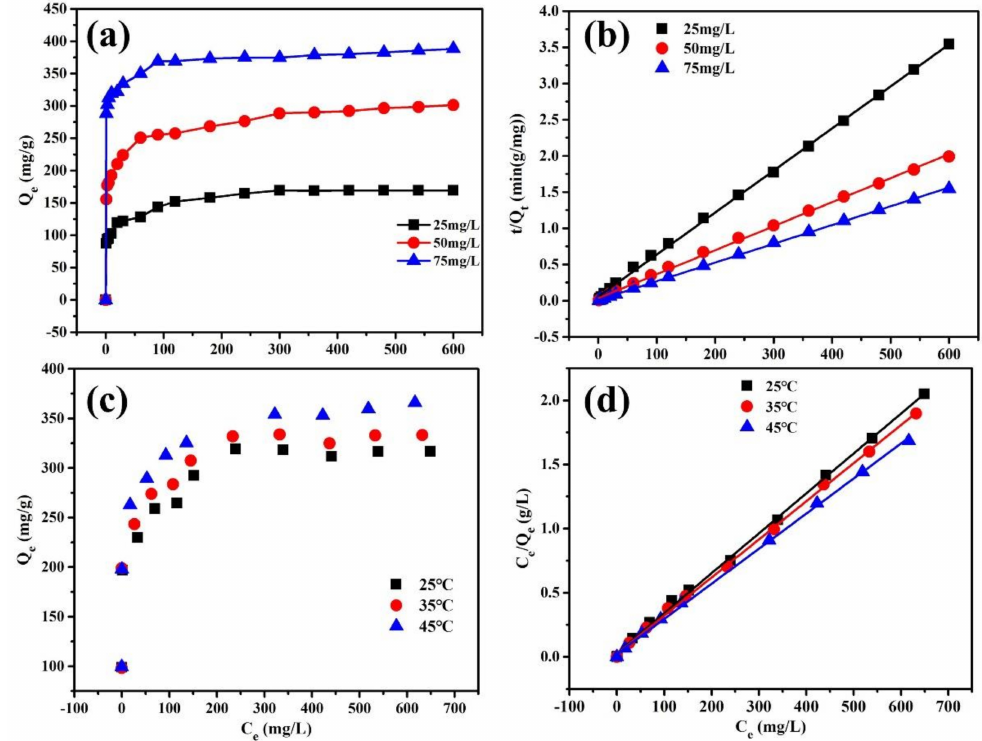
Figure 4. The adsorption kinetics ( a ) and pseudo-second-order fitting curves ( b ) of PPy / HMSNs with di ff erent initial concentrations of Cr(VI) solution, adsorption isotherms ( c ) and Langmuir model fitting curves ( d ) of PPy / HMSNs with di ff erent temperature.